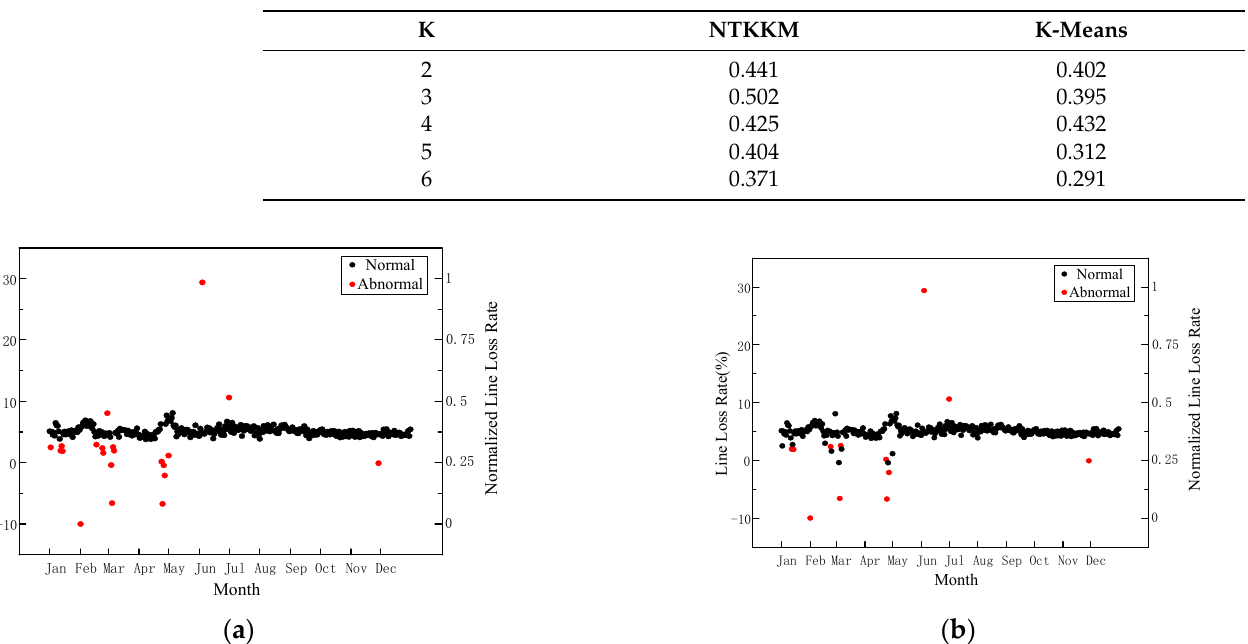
Figure 4. Distribution of historical line loss rate of data source YP. Table 1. Clustering performance comparison of different clustering algorithms.